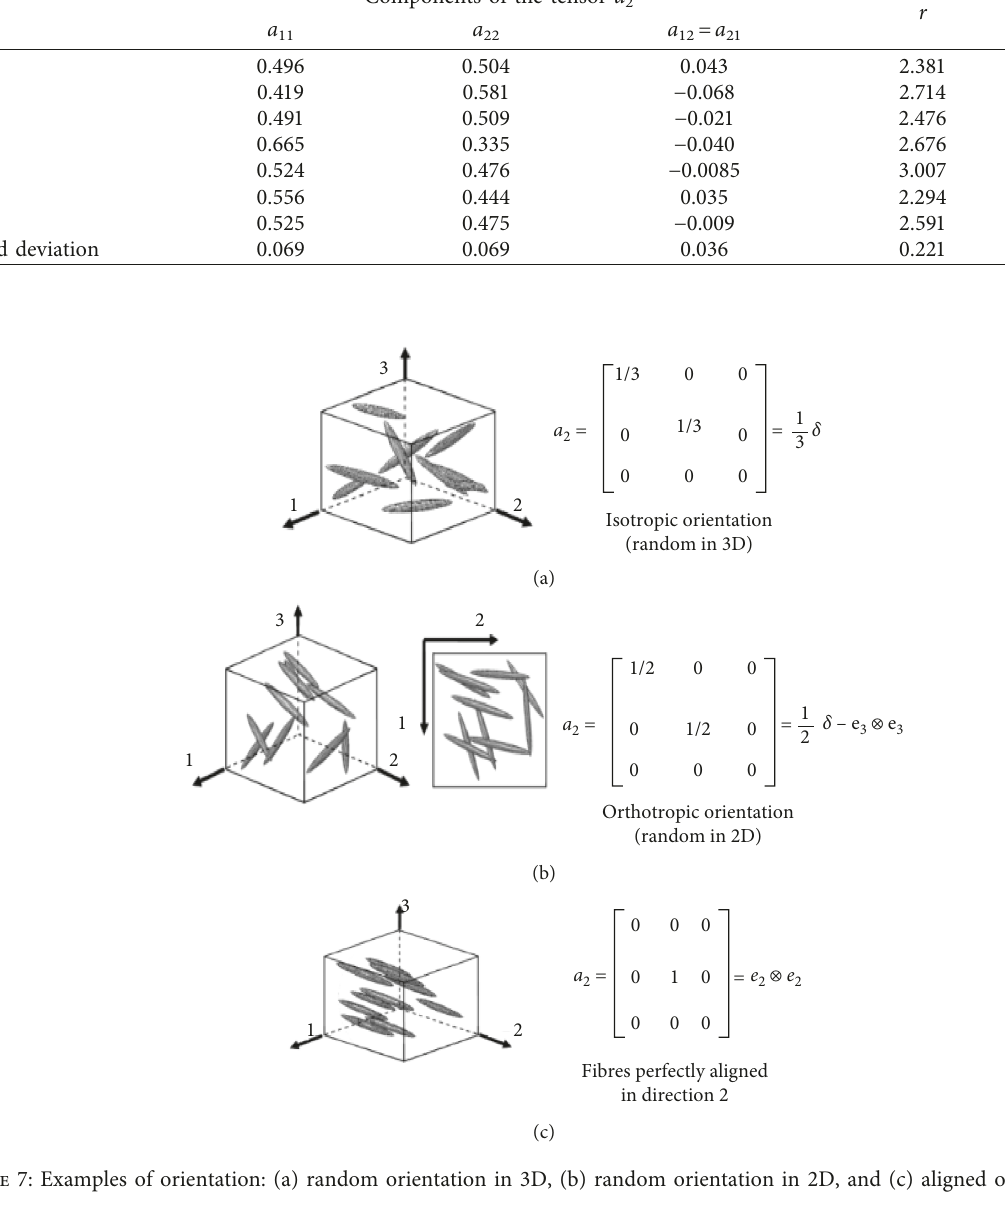
× 60 × 60mm 3 . 2 on each of the faces of the RVE of 60 r v (%) c